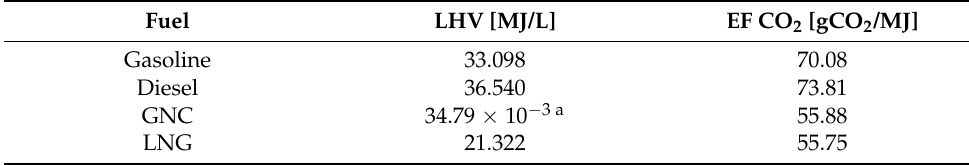
Table 4. Lower heating value of fuels